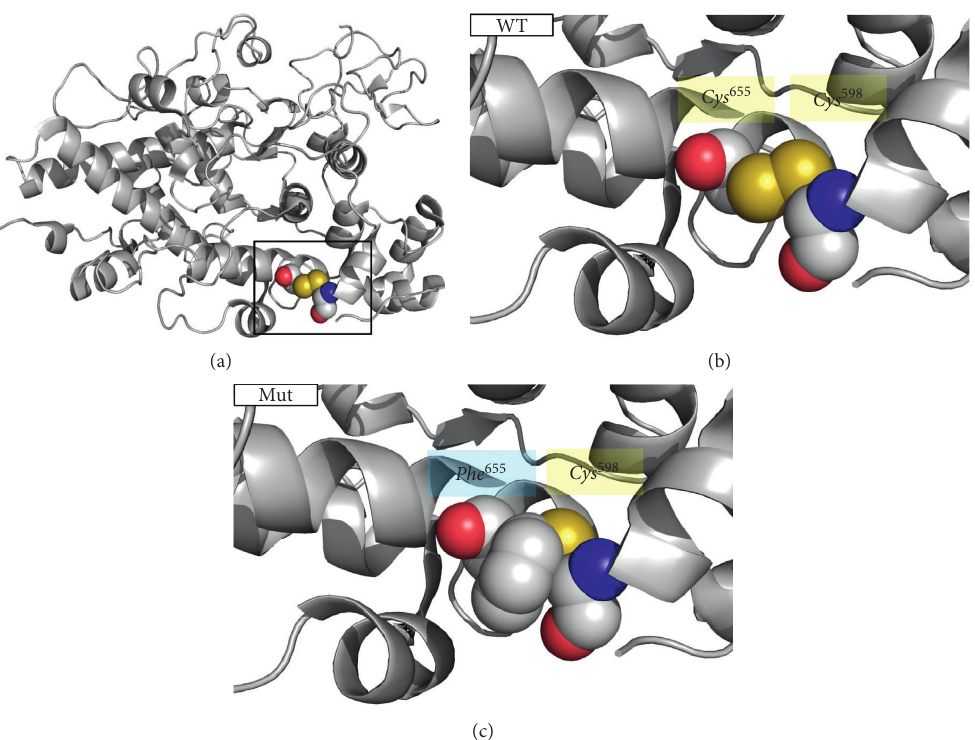
Figure 3: Conformational prediction of novel TPO mutation. (a) Human TPO structure diagram. Figures B and C are enlarged versions. (b) The wild type of Cys655 (WT). (c) The mutant type of Phe655 (Mut). These figures indicate that the substitution of p.Cys655Phe abolishes disulfide bonds between cysteines at positions 598 and 655. The yellow part is sulfur, the red part is nitrogen, the blue part is oxygen, and the gray part is